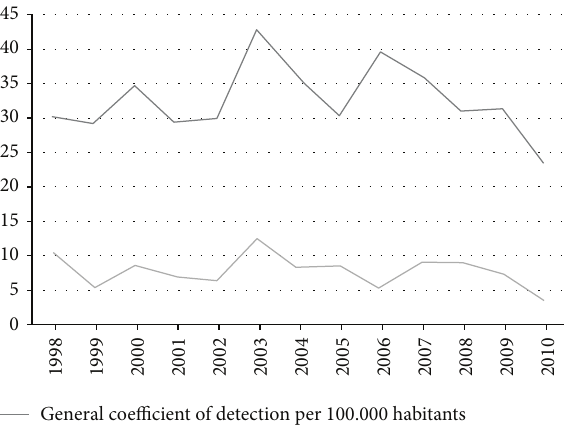
Figure 1: Coefficient of leprosy detection among the general pop- ulation and in children under 15 years old per 100.000 in habitants in Almenara, Arac¸ua´ı, and Diamantina microregions between 1998 and 2010. Table 1: Degree of deformity evaluation of notified leprosy cases in children under 15 years old in Almenara, Arac¸ua´ı, and Diamantina between 1998 and 2010. Evaluation of deformity